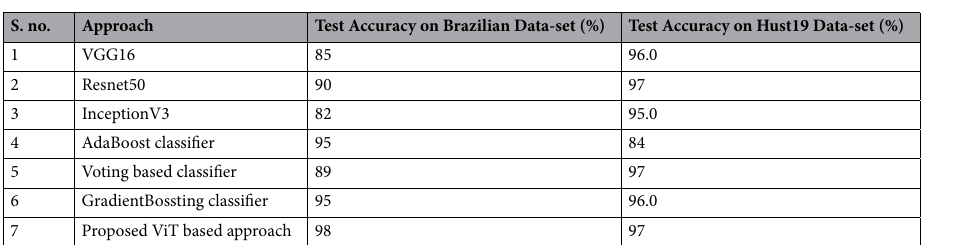
Table 1. Accuracy of classifiers on binary and multi-class data-set.